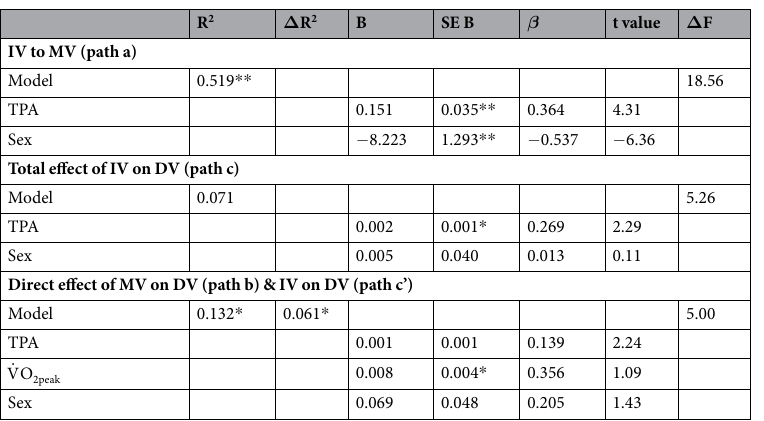
Table 3. Results of mediation analysis. Note: R 2 = coefficient of determination; B = unstandardized regression coefficient; SE = standard error. * p < 0.05, ** p <